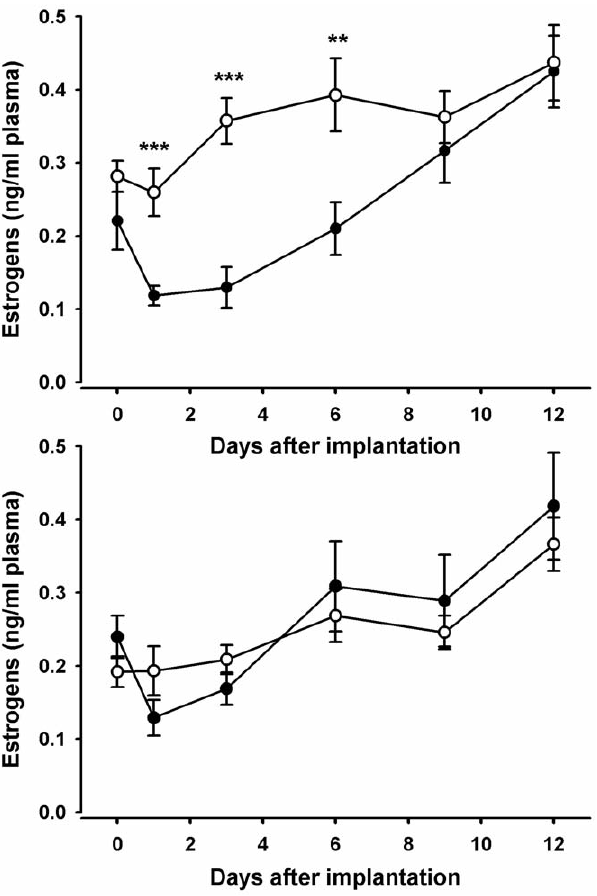
Figure 3. Estrogen concentrations in plasma after pellet implantation. Mean ( 6 SE) concentrations of estrogens in plasma of N white Leghorns (a) and ISA browns (b), after implantation with ) or placebo ( # ) pellets. Asterisks indicate significant corticosterone ( differences between treatments on individual days ( *** p #